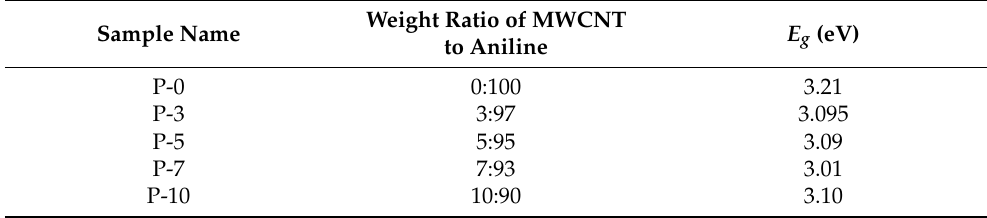
Table 1. Weight ratio of the MWCNT to aniline and the calculated optical energy gap for the investigated samples.